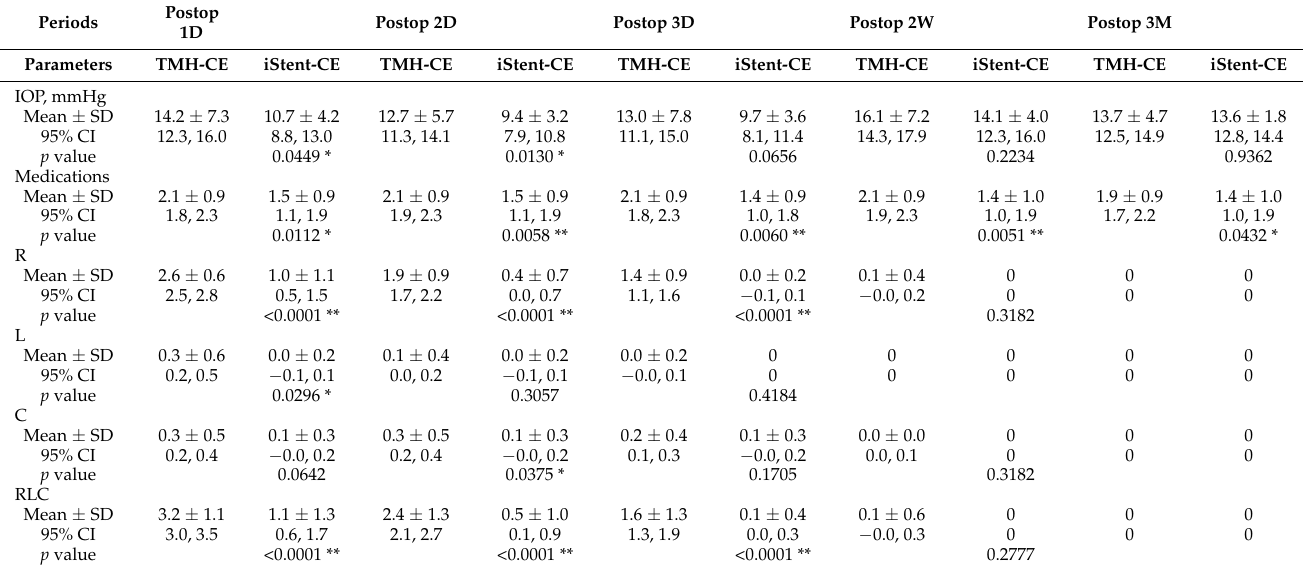
Table 3. IOP, medication, and RLC scores during follow-up.